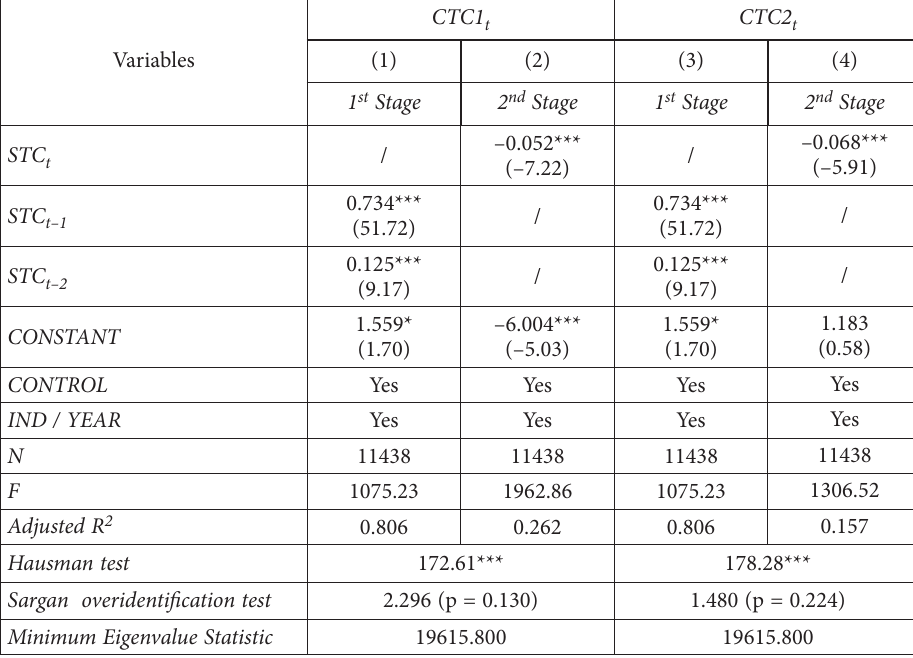
Table 6. Testing supplier’s trade credit’s relation with customer’s trade credit under cause and